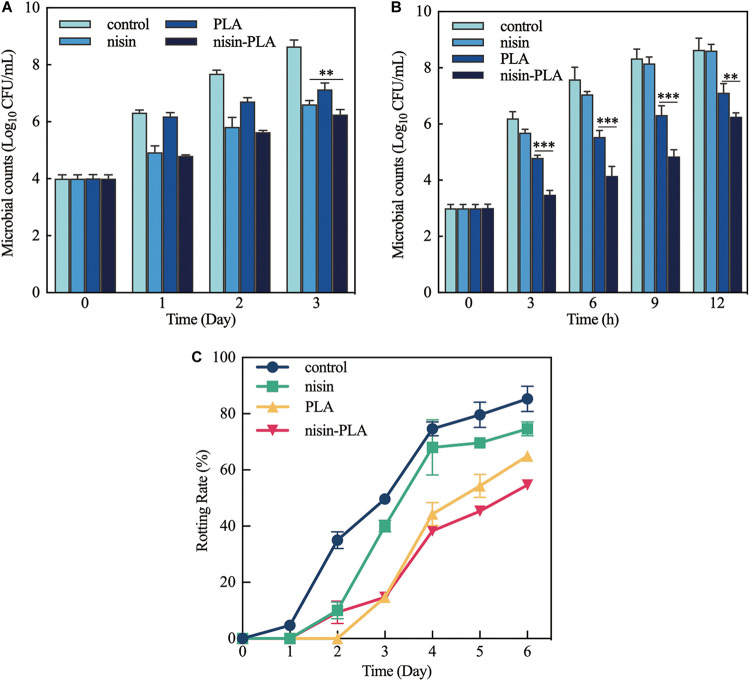
Effects of food preservation of nisin and PLA alone, or in combination. (A) Microbial changes in chilled pork stored at refrigerator (4°C), (B) microbial changes of pasteurized milk at a starting inoculum concentration of 103 CFU/mL, and (C) the rot rate of strawberry during storage at room temperature. The samples were treated with sterilized water (control), nisin (0.1%), PLA (0.1%), and nisin (0.1%)-PLA (0.1%), respectively. The data were carried out in triplicate and the standard deviation (SD) of data was shown as error bar. The differences between the four groups were determined by One-way ANOVA, and the significantly differences (**P < 0.05; ***P < 0.01) between the groups were presented in the figure.